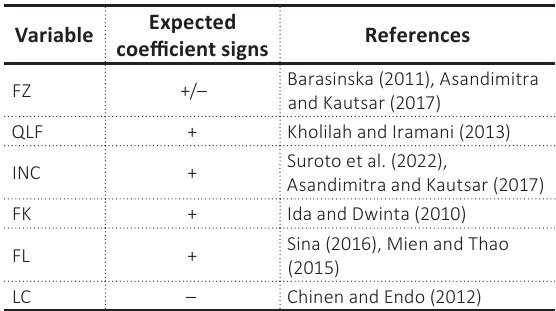
Table 1. A priori